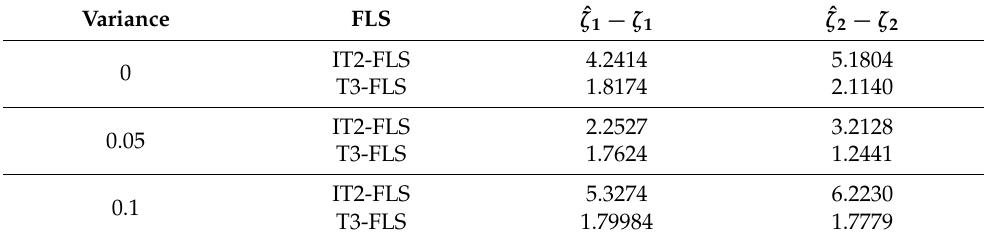
Table 2. Comparison of